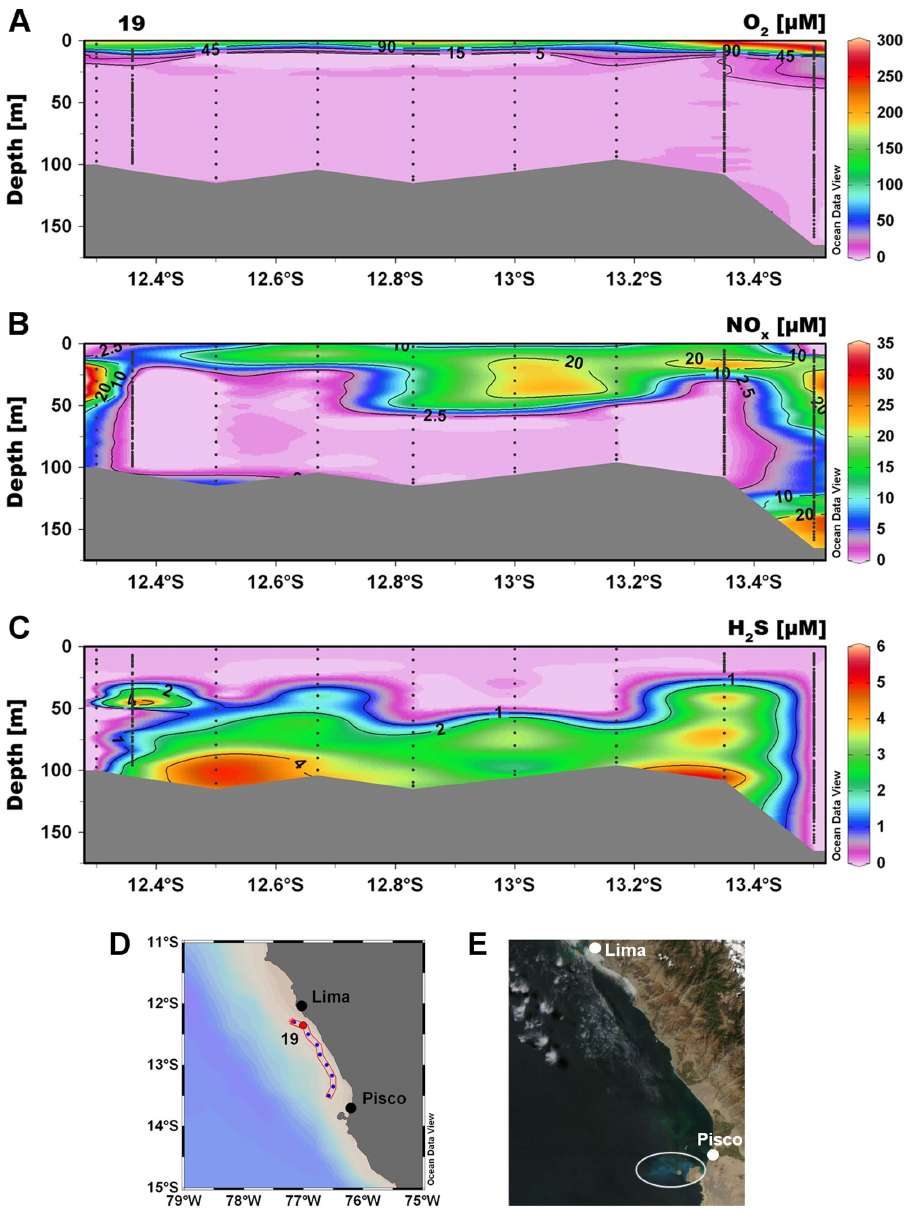
Figure 1. Extent of the sulfidic plume off the Peruvian coast. (A) Vertical distribution of O 2 concentrations. (B) Vertical distribution of NO x (the sum of NO 3 2 and NO 2 2 ) concentrations. (C) Vertical distribution of H 2 S concentrations. (D) Areal view of stations sampled along the transect off the Peruvian coast between Lima and Pisco. The station (19) that was analyzed in detail is marked with a red dot. (E) Satellite image (MODIS) showing a colloidal S 0 plume (white circle) on May 8 th , 2009.